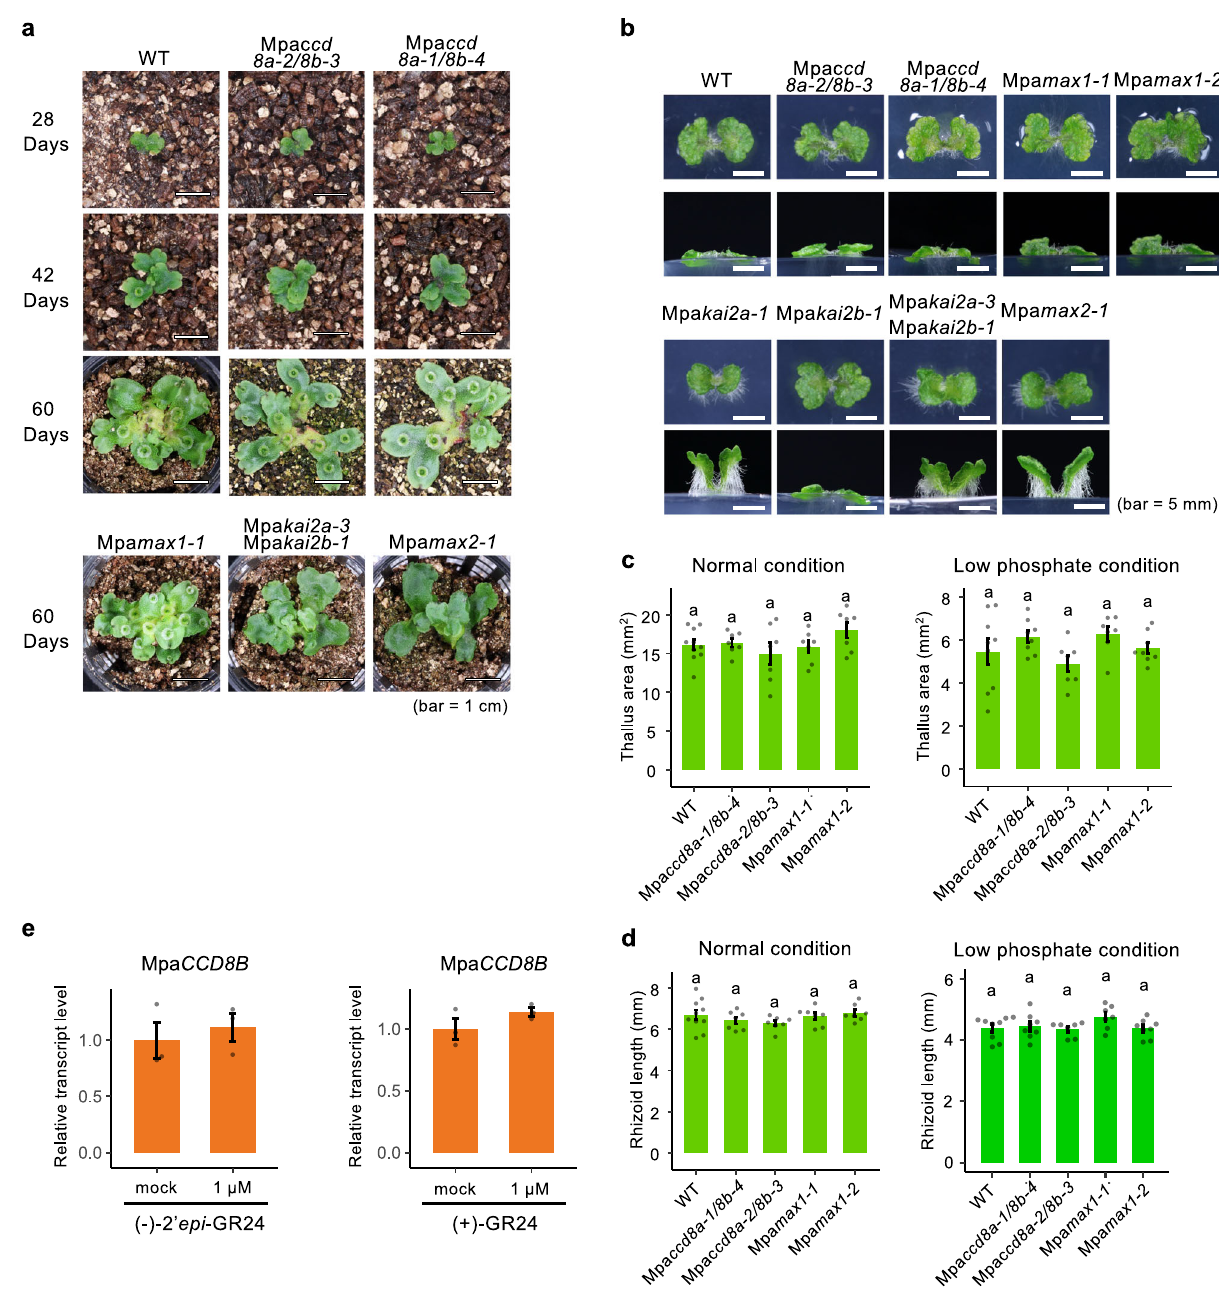
Fig. 6 BSB-de fi cient mutants of M. paleacea show no abnormal developmental patterns and gene transcript level pro fi les. Growth of BSB-de fi cient (Mpa ccd8a-2/8b-3 , Mpa ccd8a-1/8b-4, Mpa max1-1 and Mpamax1-2 ) and KAI2 signaling (Mpa kai2a-1 , Mpa kai2b-1 , Mpa kai2a-3 Mpa kai2b-1 and Mpa max2-1 ) mutants of M. paleacea grown in soil for 28, 42 and 60 days ( a ) and in media for 20 days ( b ). Thallus area and rhizoid length of BSB-de fi cient mutants of M. paleacea grown on half-strength Gamborg ’ s B5 medium containing 560 μ M ( c ) and 56 μ M ( d ) phosphorus (NaH 2 PO 4 ) for 14 days. Data in c , d are means ± SD ( n ≥ 7 biologically independent plants) and the HSD test was used for multiple comparisons. Statistical differences ( p values <0.05) are indicated by different letters. e Transcript level of Mpa CCD8B in WT plants after ( − )-2 ′ - epi -GR24 and ( + )-GR24 treatments. Data are means ± SD ( n = 3 biologically independent